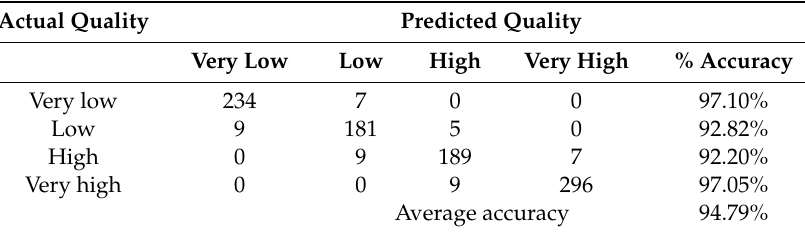
Table 2. Confusion matrix for quality inspection using k = 10.